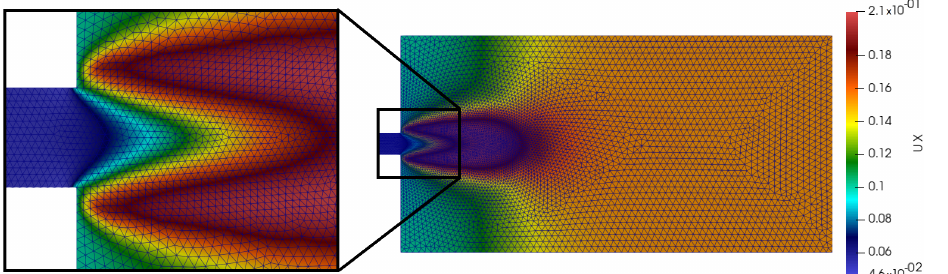
Figure 3. Illustration of the mesh and the example of the x-component of an instantaneous velocity field of the considered test-case.